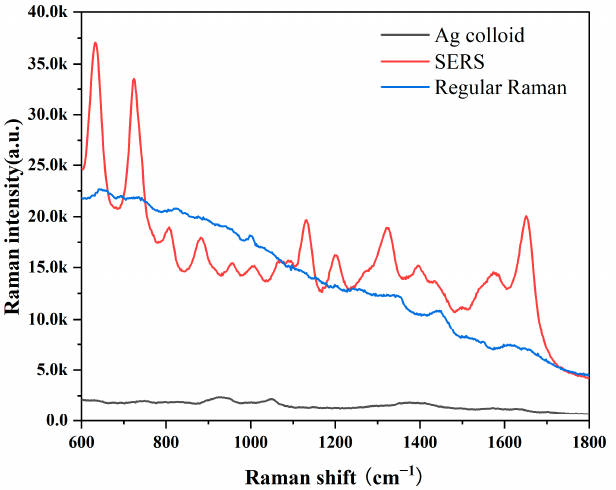
Figure 1. Comparison of SERS, RS and background Raman signal of Ag colloid; The blood serum patient with GB stone was mixed with Ag colloid in a 1:1 ratio to obtain SERS spectra of the serum (Red line); Conventional Raman spectra of free Ag colloid in the same sample (Blue line); Background Raman signal of Ag colloid (Black line).